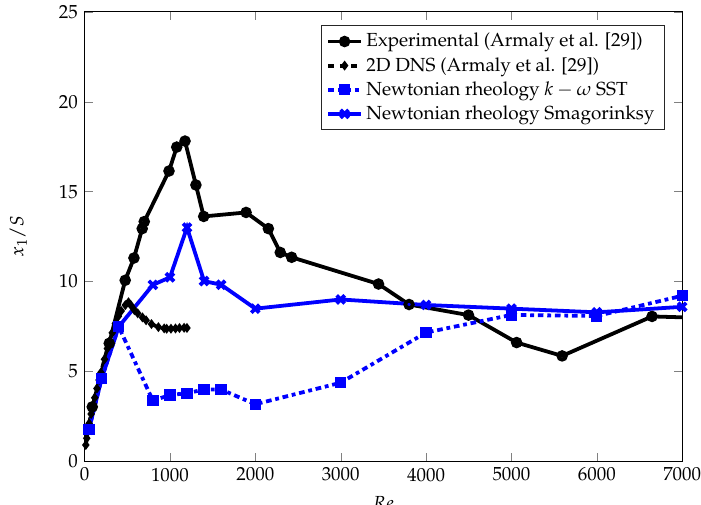
Figure 5. Time-averaged and spatially averaged primary recirculation x 1 normalised by step height S of Newtonian blood rheology is plotted as a function of Reynolds number. Experimental data (black line) and 2D DNS calculation from Armaly et al. [29] are also shown.